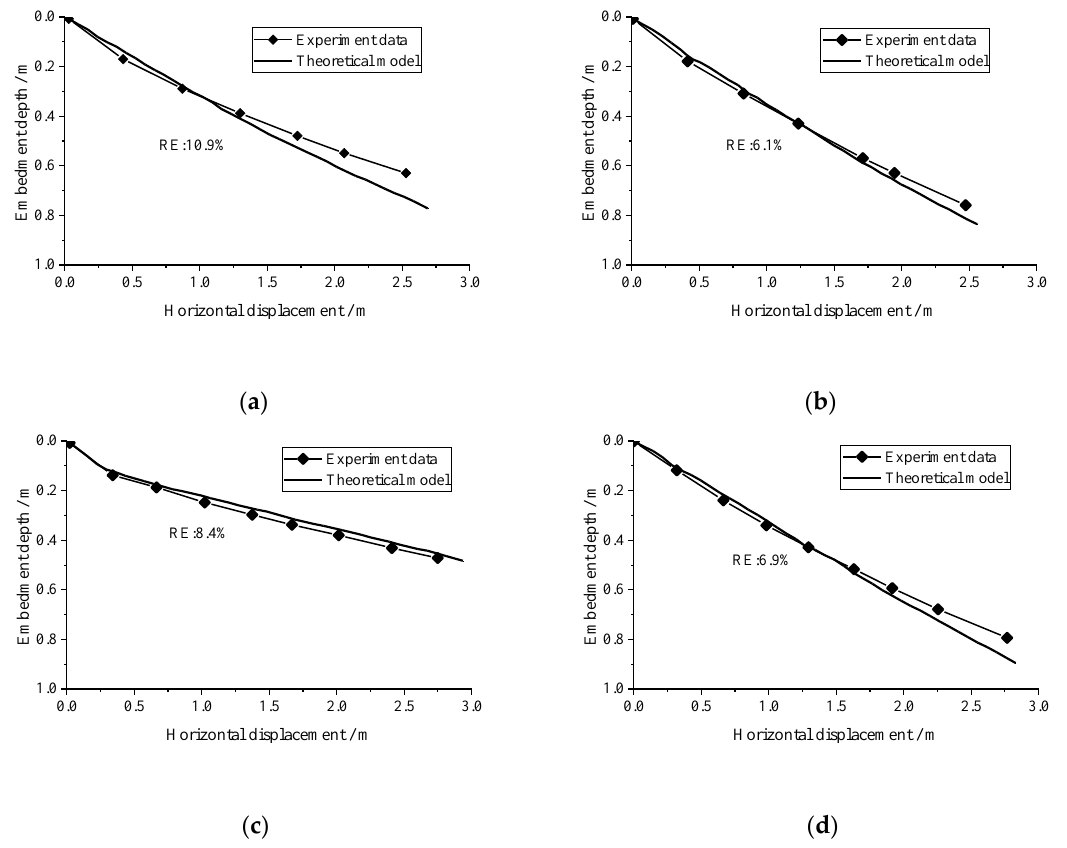
 = 29.5° (rectangular anchor); ( b )  = s s